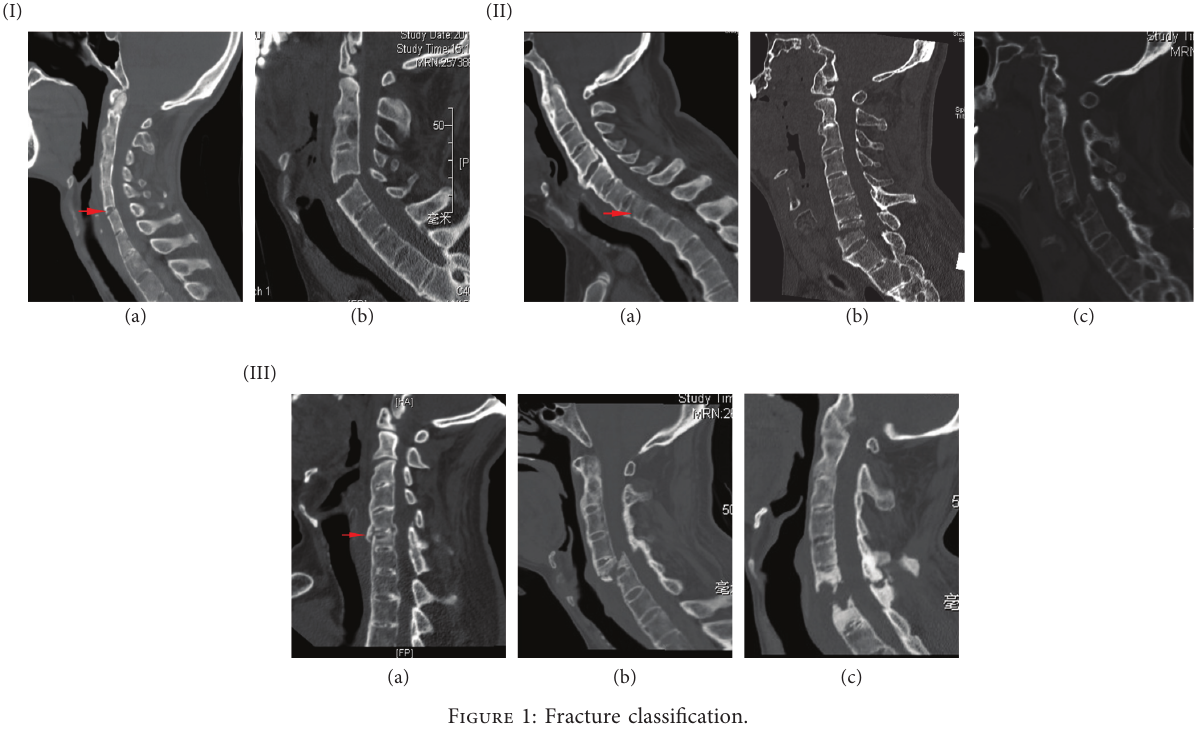
Figure 1: Fracture